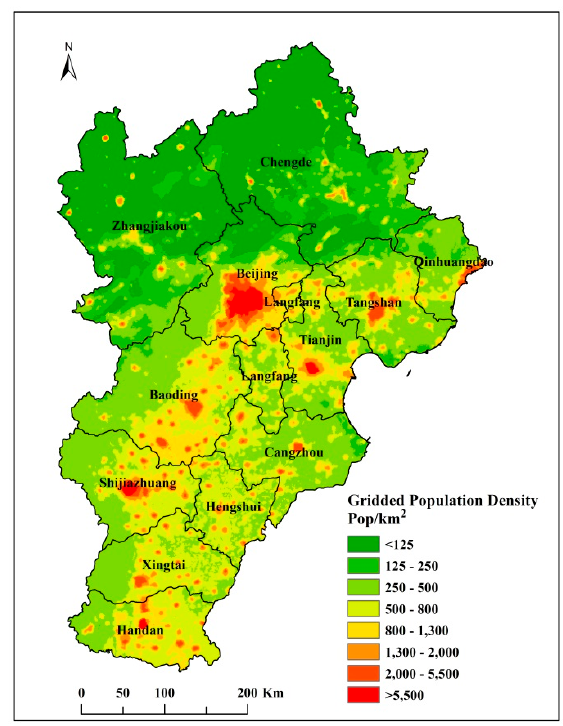
Figure 4. The population density across the BTH region in 2016.